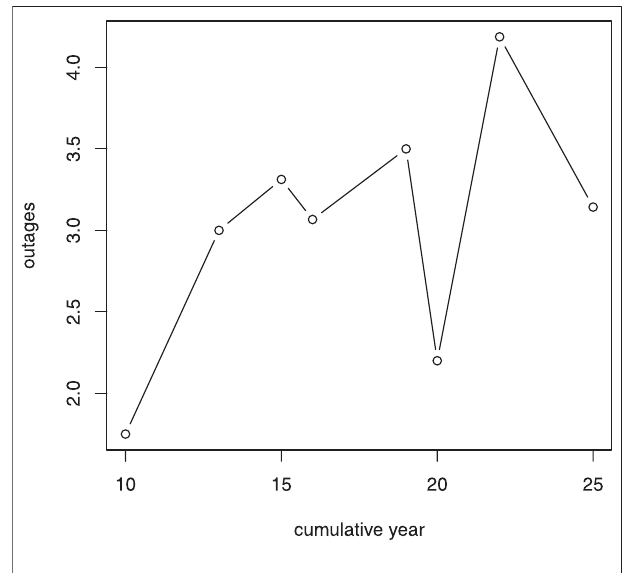
FIGURE 2 | Mean outages over cumulative